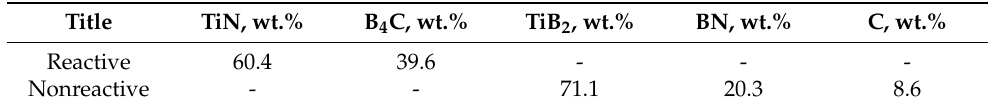
Table 1. The green body